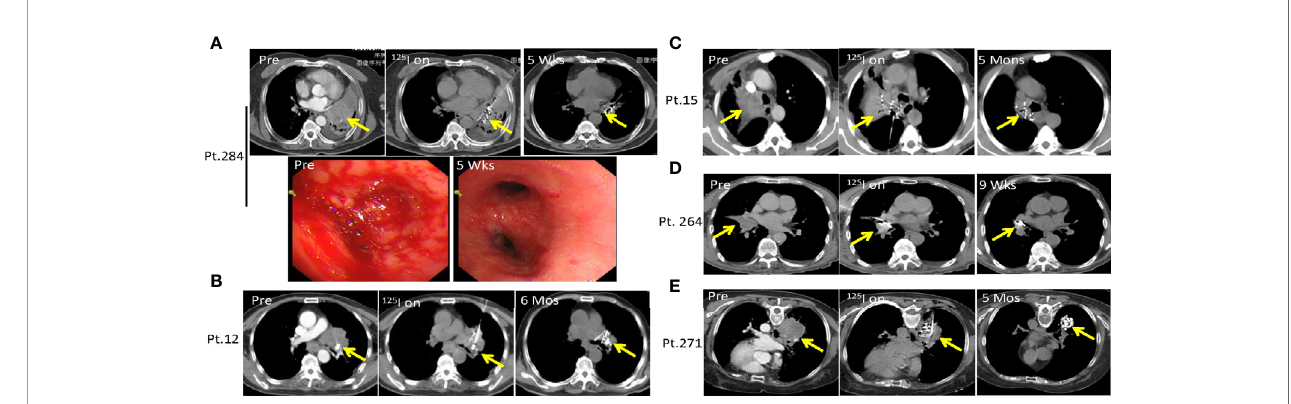
FIGURE 5 | SNCP- 125 I brachytherapy successfully alleviates life-treatening hemoptysis in advanced lung cancer. (A). Patient 284 with squamous cell carcinoma in the hilar region of the right lung progressed on chemotherapy and developed hemoptysis, with the tumor also blocking the main trachea accompanied by dyspnea and atelectasis. Following SNCP- 125 I brachytherapy, bleeding was successfully stopped as shown under the tracheoscopy examination 5 weeks later. (B – E) Patients 12, 15, 264 and 271 with lung squamous cell carcinoma developed hemoptysis and progressed after unsatis fi ed treatment of hemostatic drugs.